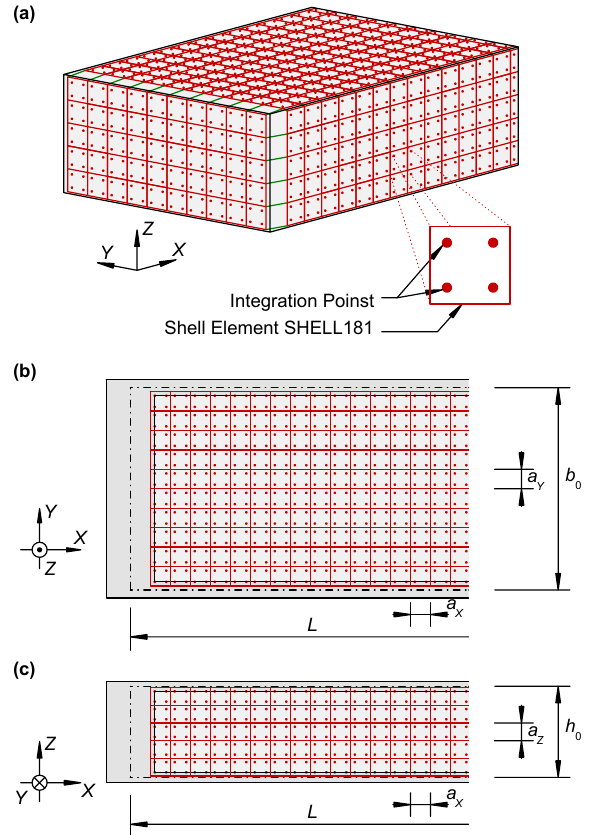
Figure 2. Detail of the CMM finite element within ANSYS to generate the